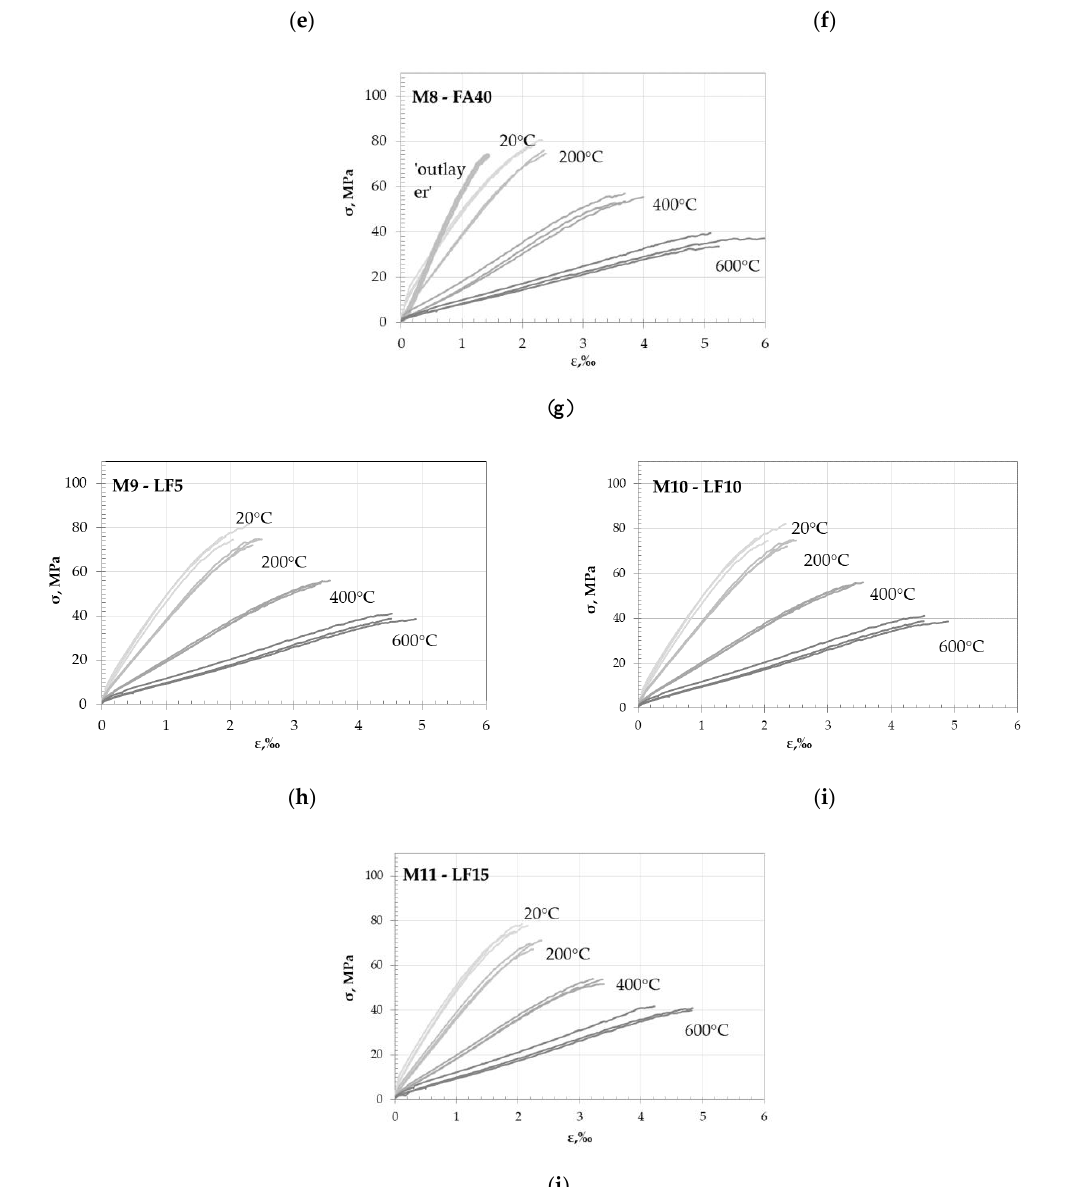
Figure A3. Stress – strain curves of the tested mixes: ( a ) reference mix; ( b – d ) mixes with metakaolin; ( e – g ) mixes with fly ash; ( h – j ) mixes with limestone.